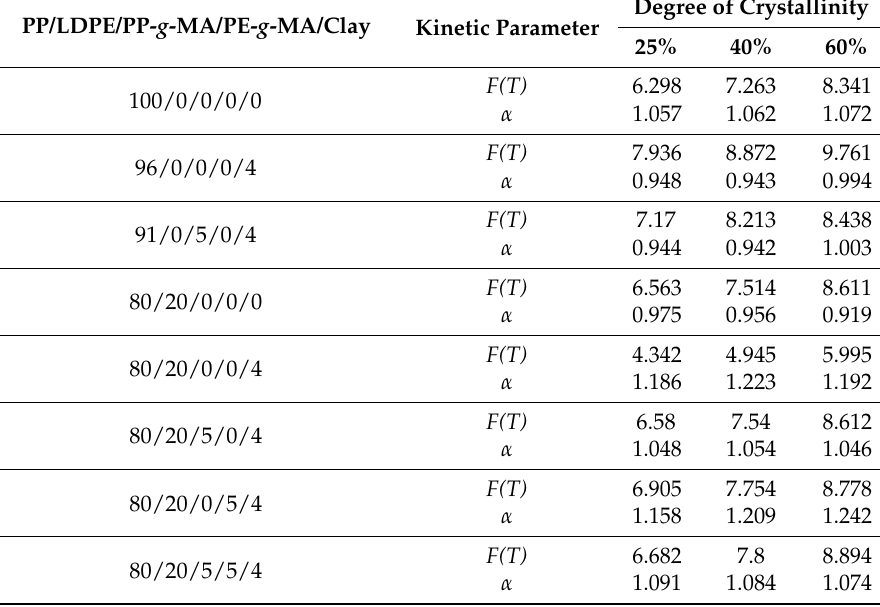
Table 3. Kinetic parameters based on the Liu